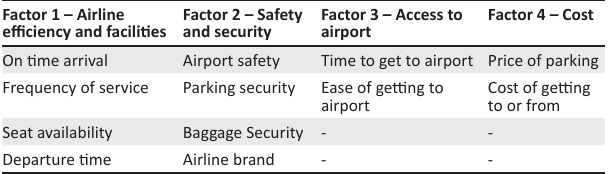
TABLE 7: Latent factor structure of attributes.